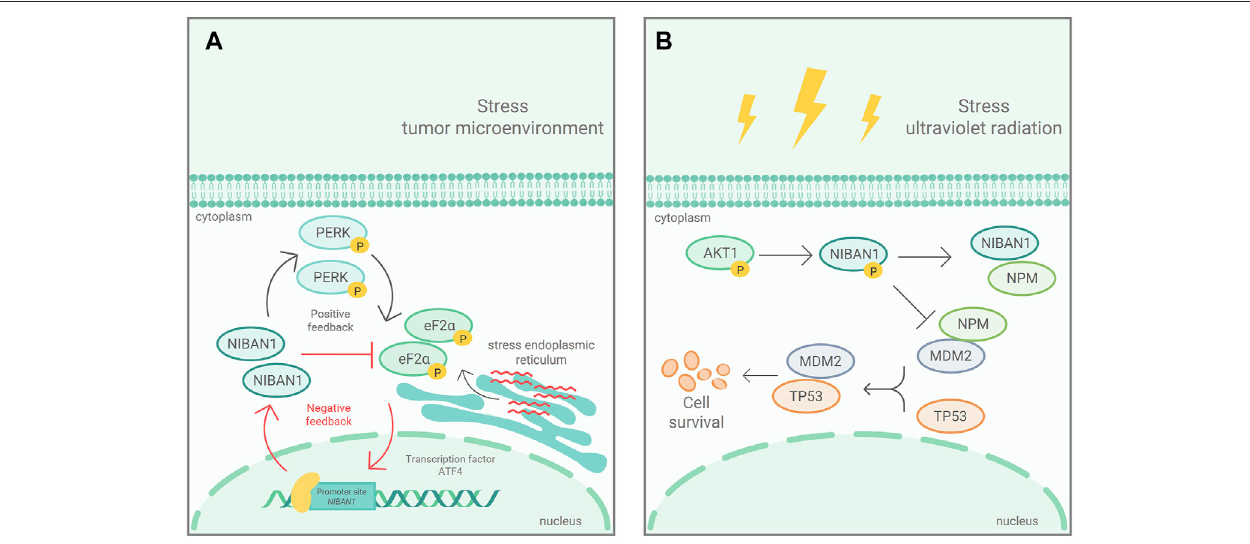
FIGURE 2 | Mechanism of NIBAN1 action in two cancerous contexts: (A) In response to ER stress, in prostate cancer, eIF2 α is phosphorylated, via PERK, and activates ATF4, which induces NIBAN1 expression. NIBAN1 , in turn, inhibits eIF2 α phosphorylation, in a negative feedback limiting cell death. Modi fi ed fi gure from Pällmann et al. (2019). (B) In response to ultraviolet ra-diation, NIBAN1 is phosphorylated, by AKT, in Ser602. pSer602- NIBAN1 binds to NPM, preventing NPM from binding to MDM2. Thus, free MDM2 interacts with p53, leading to polyubiquitination and its subsequent degradation. Modi fi ed fi gure from Ji et al. (2012).